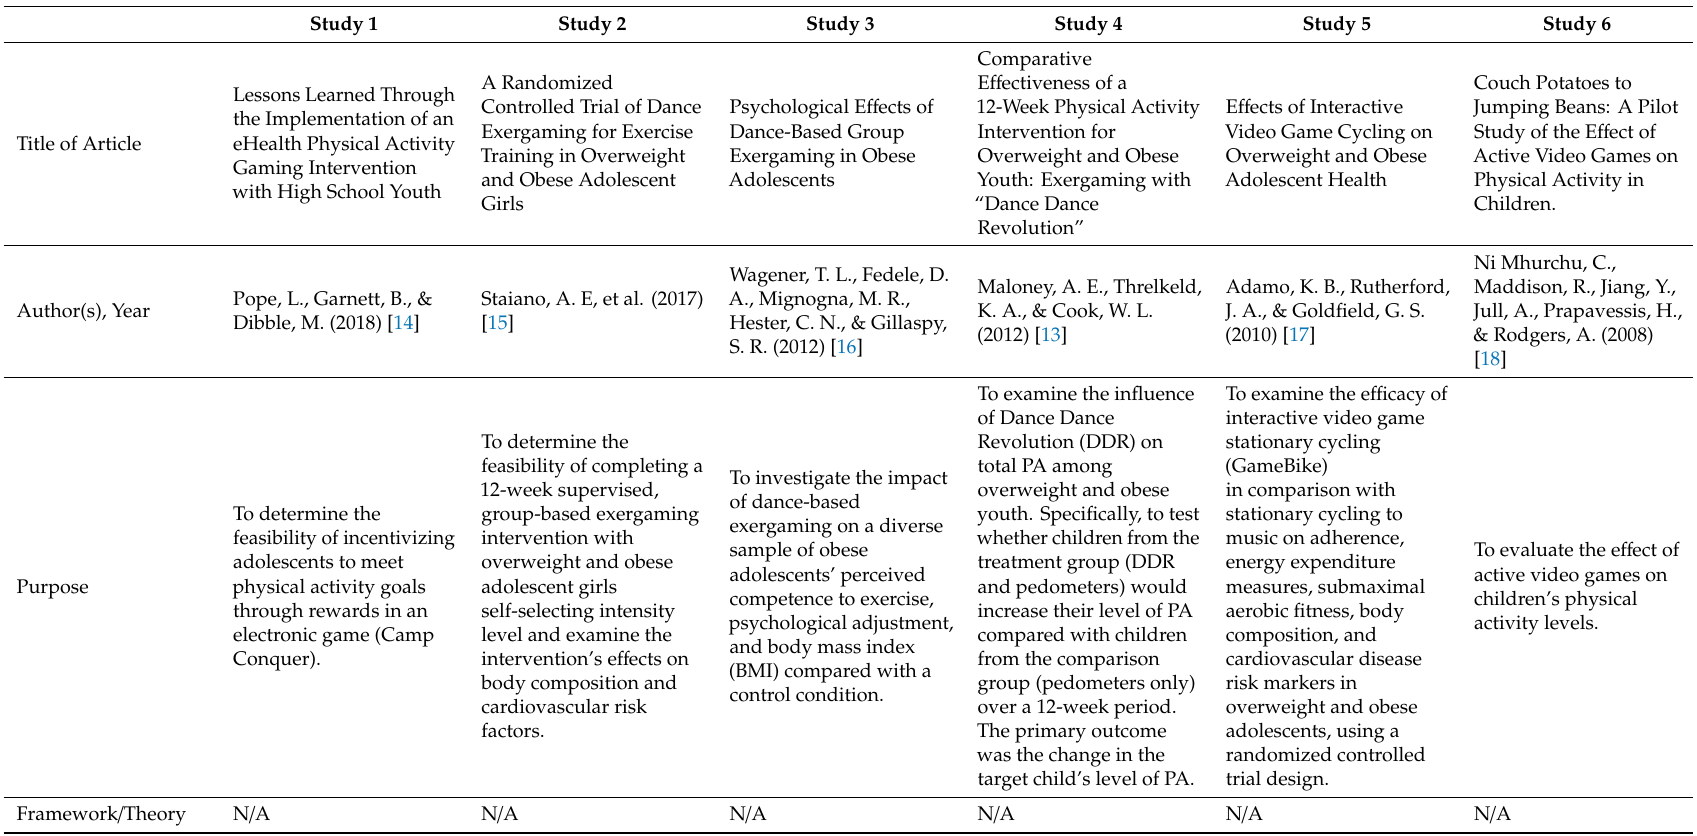
Table 1. Gaming and physical activity (PA): summary of studies that explored the use of active video games (AVGs) or exergames for